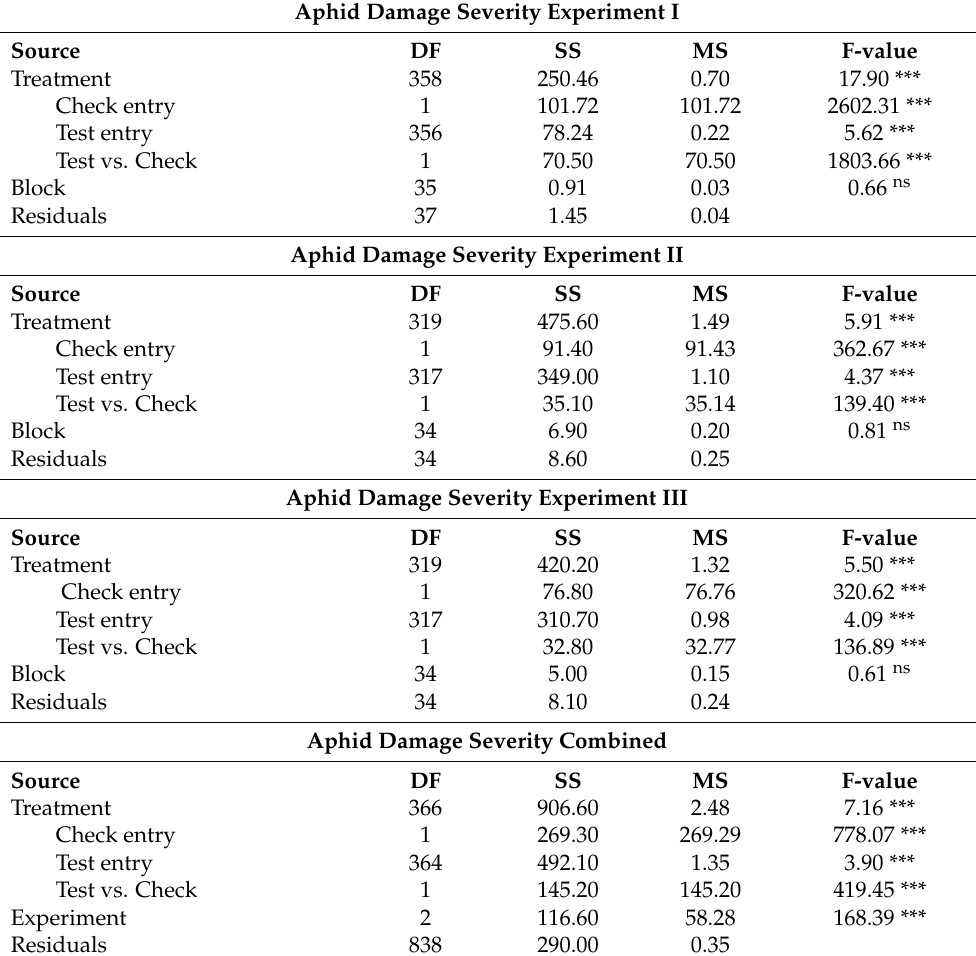
Table 1. Analysis of variance for aphid damage severity in the cowpea mini-core population evaluated in three experiments, each established in an augmented block